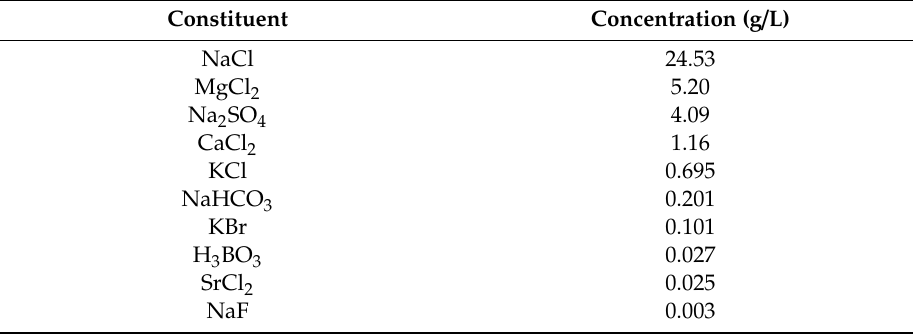
Table 4. Chemical composition of the artificial seawater.